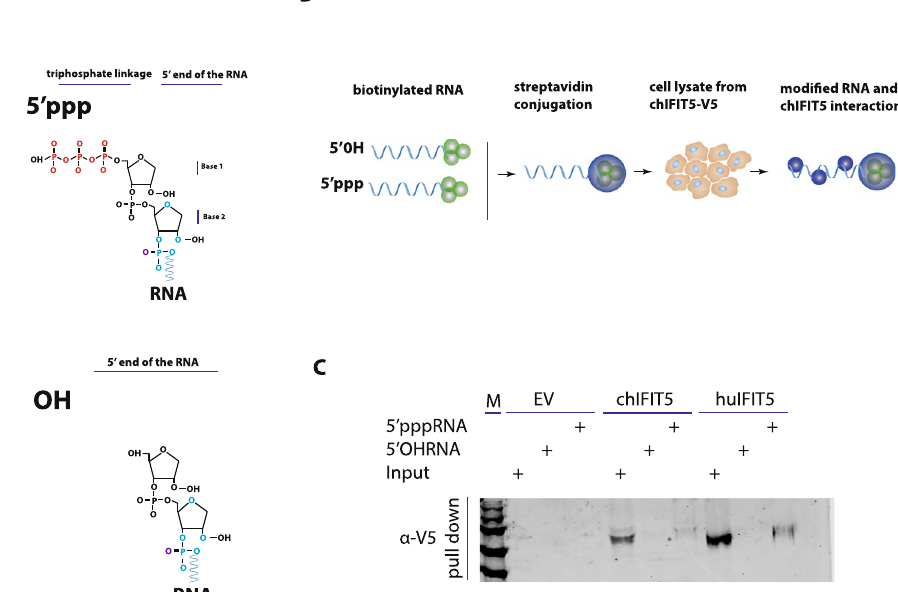
Figure 7. Interaction of chIFIT5 with RNA carrying modifications in their 5 ′ termini using RNA-protein immunoprecipitation. ( A ) The genomes of negative sense single stranded RNA viruses carry triphosphate linkage (5 ′ ppp) in the first transcribed base of the RNA and removal of 5 ′ ppp structure will leave non-IFN stimulatory hydroxyl group (OH). ( B ) RNA carrying both 5 ′ ppp and OH termini were biotinylated and coated on streptavidin beads before interaction with V5-tagged chIFIT5. Total ribonucleoproteins were isolated and stained for the V5 tag. ( C ) Pull down of biotinylated RNA interacting with chIFIT5 indicated that both human and chicken IFIT5 interacted with RNA carrying 5 ′ ppp structures. EV = empty vector, M =